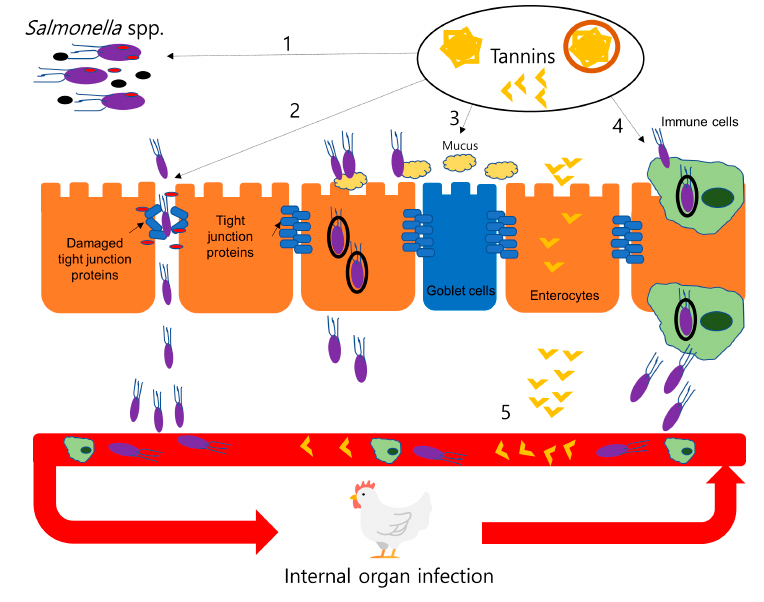
Figure 2. Systemic infection routes of Salmonella spp. and potential mechanisms of antibacterial actions of tannins in an in-vivo chicken model. Chickens can orally ingest Salmonella spp. from feed or their environment, and subsequently escape the small or large intestine [75]. (1) Tannins and tannin derivatives (tannins, hydrolyzed tannins, and tannin-protein complexes) are known to inhibit the growth of Salmonella spp. in the intestine and decrease quorum sensing of the bacteria [61]. Lipopolysaccharides (LPS) of Salmonella spp. can impair intestinal barrier function, which allows Salmonella spp. to pass the paracellular pathways of the intestine [76,77]. (2) Tannins and tannin derivatives may improve gut barrier integrity by neutralizing LPS or decreasing expression of cytokines, which can impair tight junction proteins [78]. (3) and (4) Salmonella spp. also utilized mucus and immune cells to invade epithelial cells [71]. Tannins and their derivates potentially modulate expression and morphology of immune cells and mucus. Salmonella spp. can invade epithelial cells in diverse pathways and enter blood circulation and finally colonize in internal organs (e.g., liver, kidney, spleen, etc.) and muscles